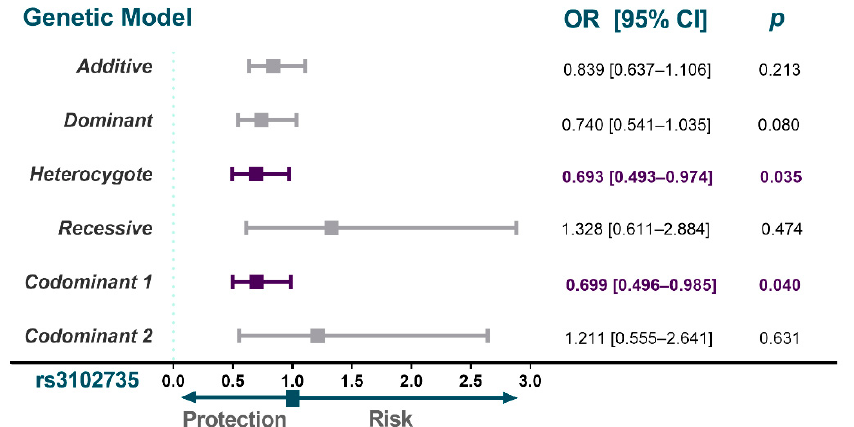
Figure 2. Association analysis of OPG gene polymorphisms with SA. The models shown were ad- justed by sex, age, BMI, smoking habits, diabetes mellitus, LDL-cholesterol, subcutaneous abdominal fat, alkaline phosphatase, alanine transaminase and aspartate transaminase activities, apolipoprotein AI concentrations and phosphorus and calcium serum concentration. SA, subclinical atherosclerosis; MAF, minor allele frequency; OR, odds ratio; CI, confidence interval.